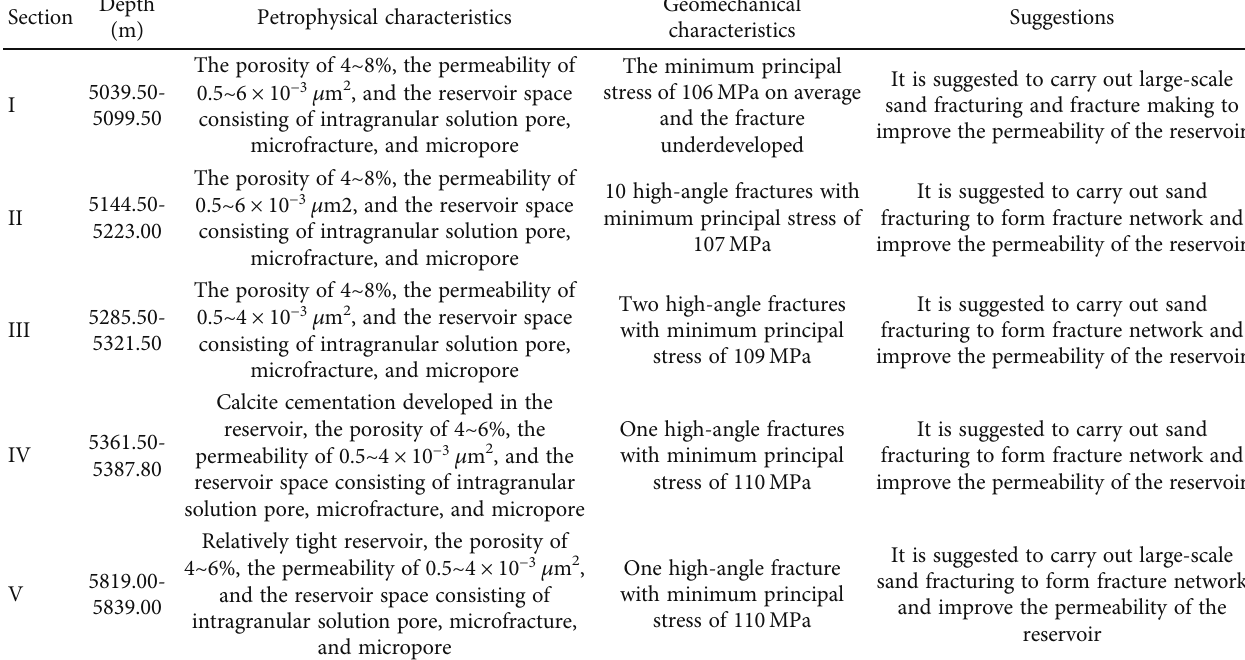
Table 1: Fracturing interval and transformation suggestions based on reservoir characteristics and geomechanical analysis. Depth Section